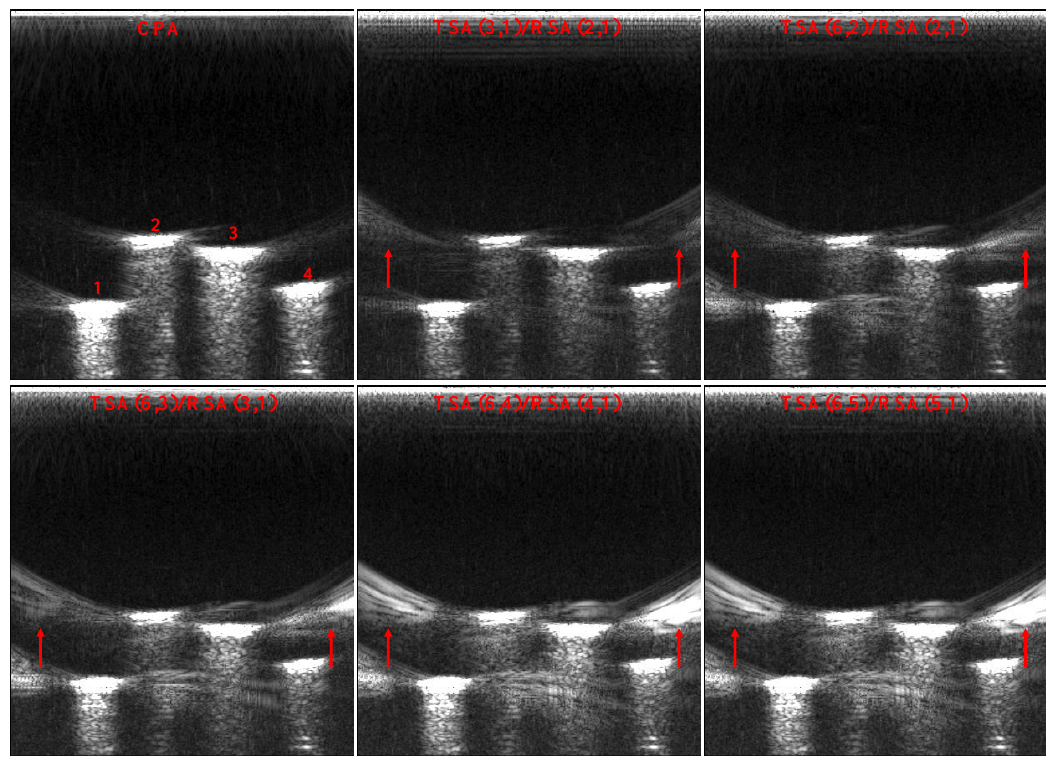
=1/ 6 SF two way  ). Figure 13. Imaging results of different CMUT sparse array configurations ( SF two − way = 1/6).